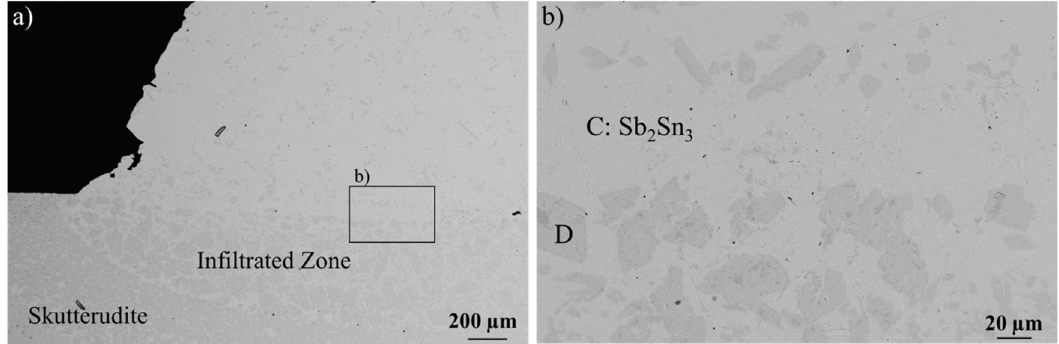
Figure 10. ( a ) SEM-EDS micrograph (BSE) of the cross-section of Fe50_SPS after interaction with pure Sn at 773 K. ( b ) SEM-EDS (BSE) magnification of a selected area indicated by rectangle in ( a ) Table 4. EDS chemical analysis (at. %) of different regions identified in the wetting samples tested with Sn and indicated in Figure 9 (regions A and B) and 10 (regions C and D); at least five spots were analyzed for each phase.